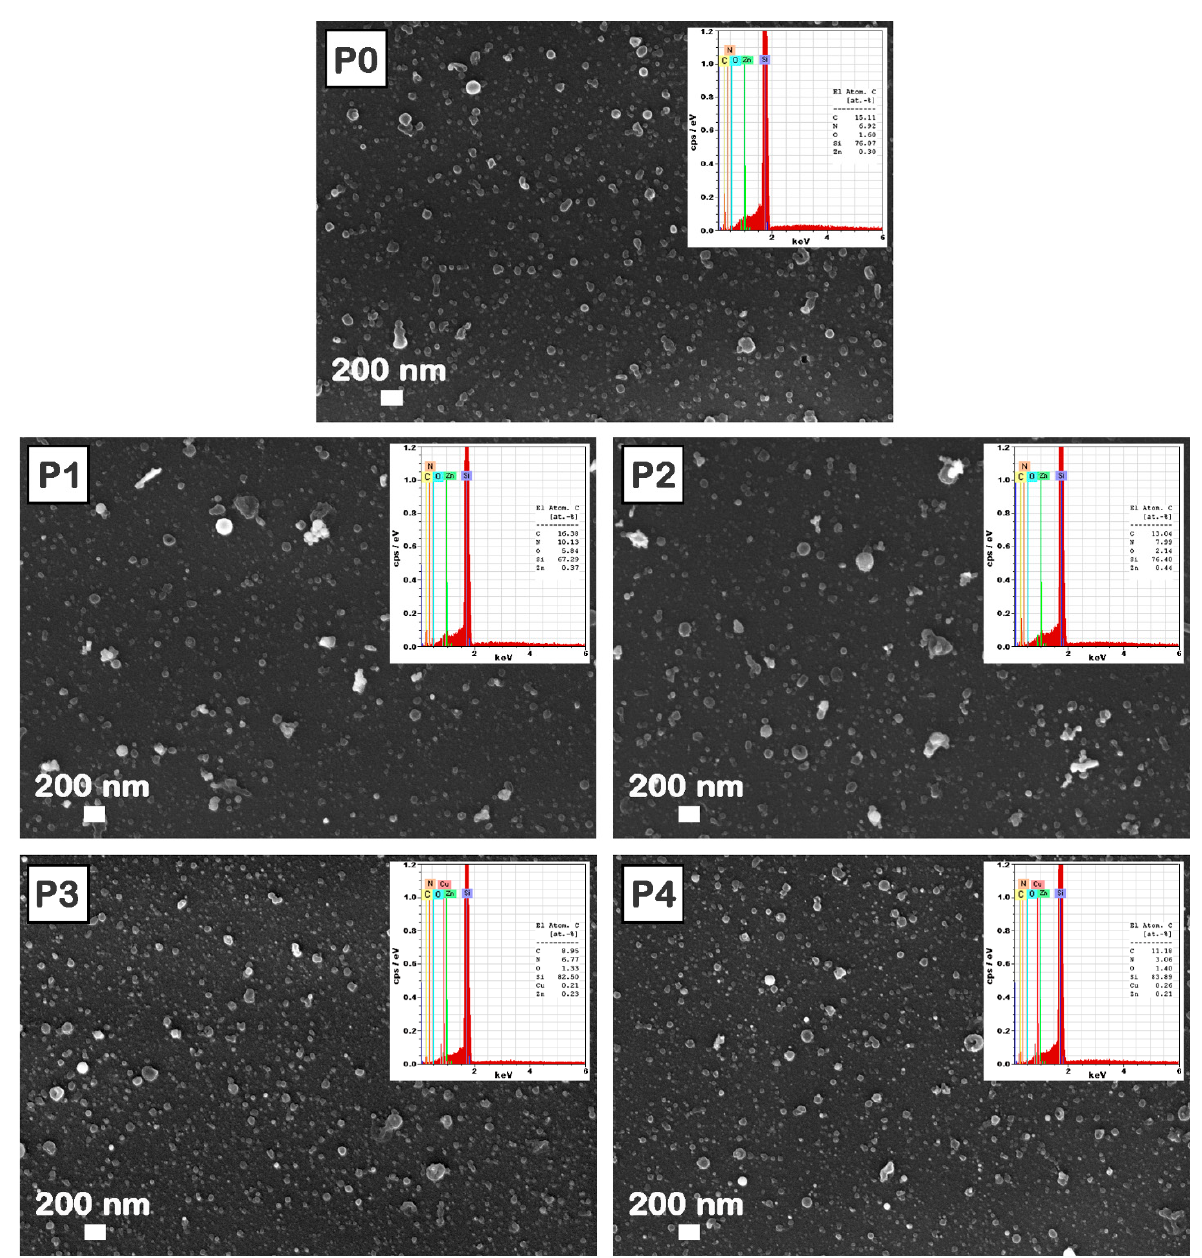
Figure 4. FESEM images of the P0–P4 films deposited by MAPLE on silicon. Insets: EDX spectra and atomic percentages of the elements in the corresponding samples.